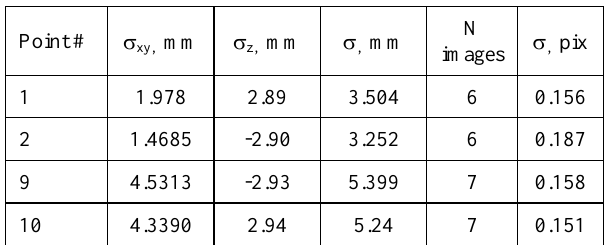
Table 4. Measurements precision (reference points)